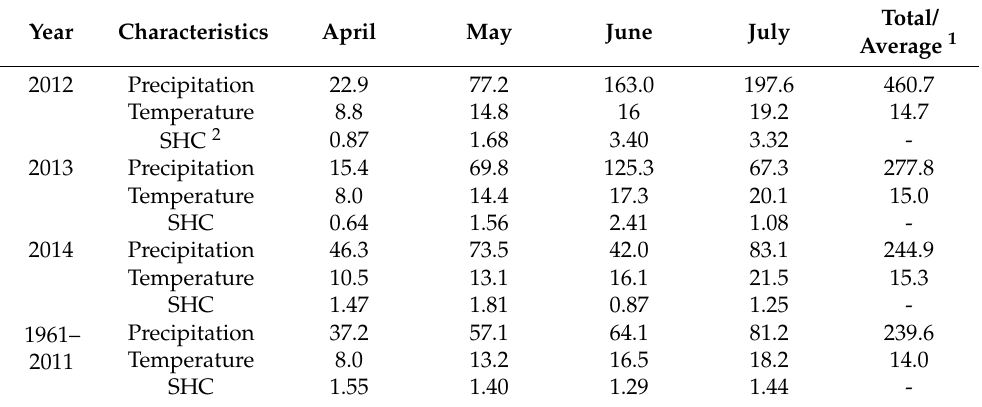
Table 3. Mean monthly air temperature ( ◦ C) and sum of precipitation (mm) during growing seasons of faba bean on the background of the long-term